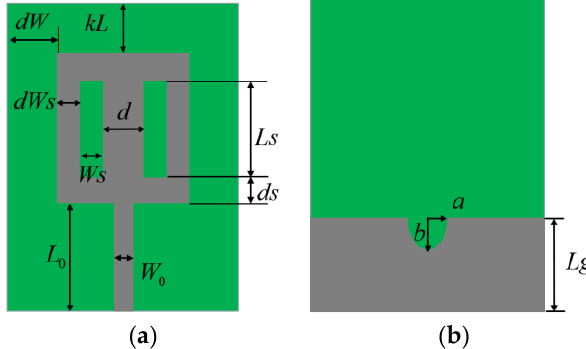
Figure 10. UWB antenna structure: ( a ) the front view; ( b ) back view. The gray part is the metal patch and the green part is the dielectric substrate.